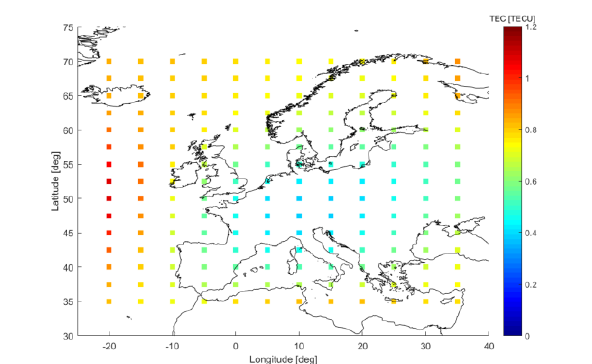
Figure 1. CODE model’s annual average RMS values in 2018.